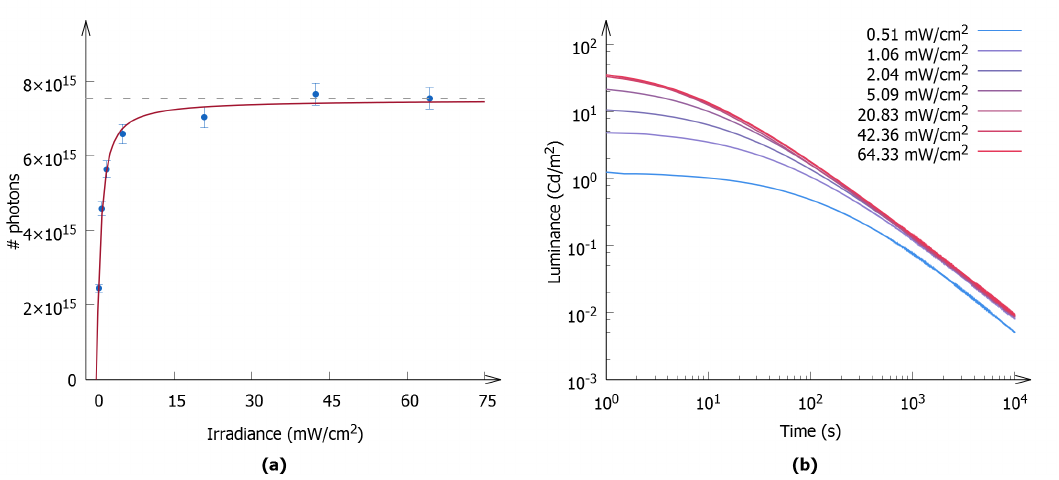
Figure 4. ( a ) The measured storage capacity for SrAl 2 O 4 :Eu,Dy (blue dots) as a function of the irradiance of the excitation light during charging. The first data point, at the lowest excitation intensity, corresponds to the experimental conditions used for the experiments shown in Figure 3. The red line is a guide for the eye; ( b ) The decay curves for different excitation